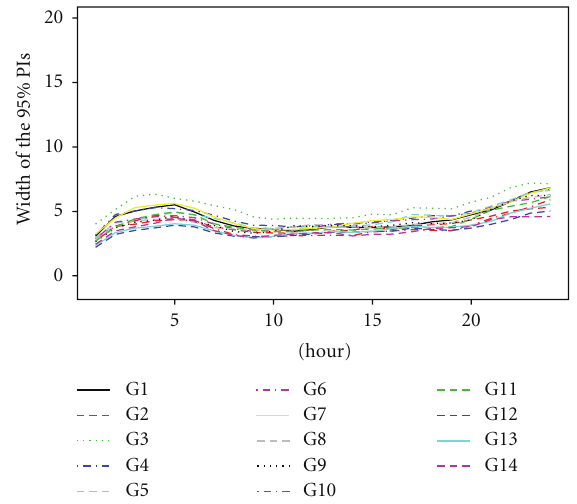
Figure 4: The width of the 95% pointwise predictive intervals of the one-day-ahead prediction at 14 gauged sites using M1.